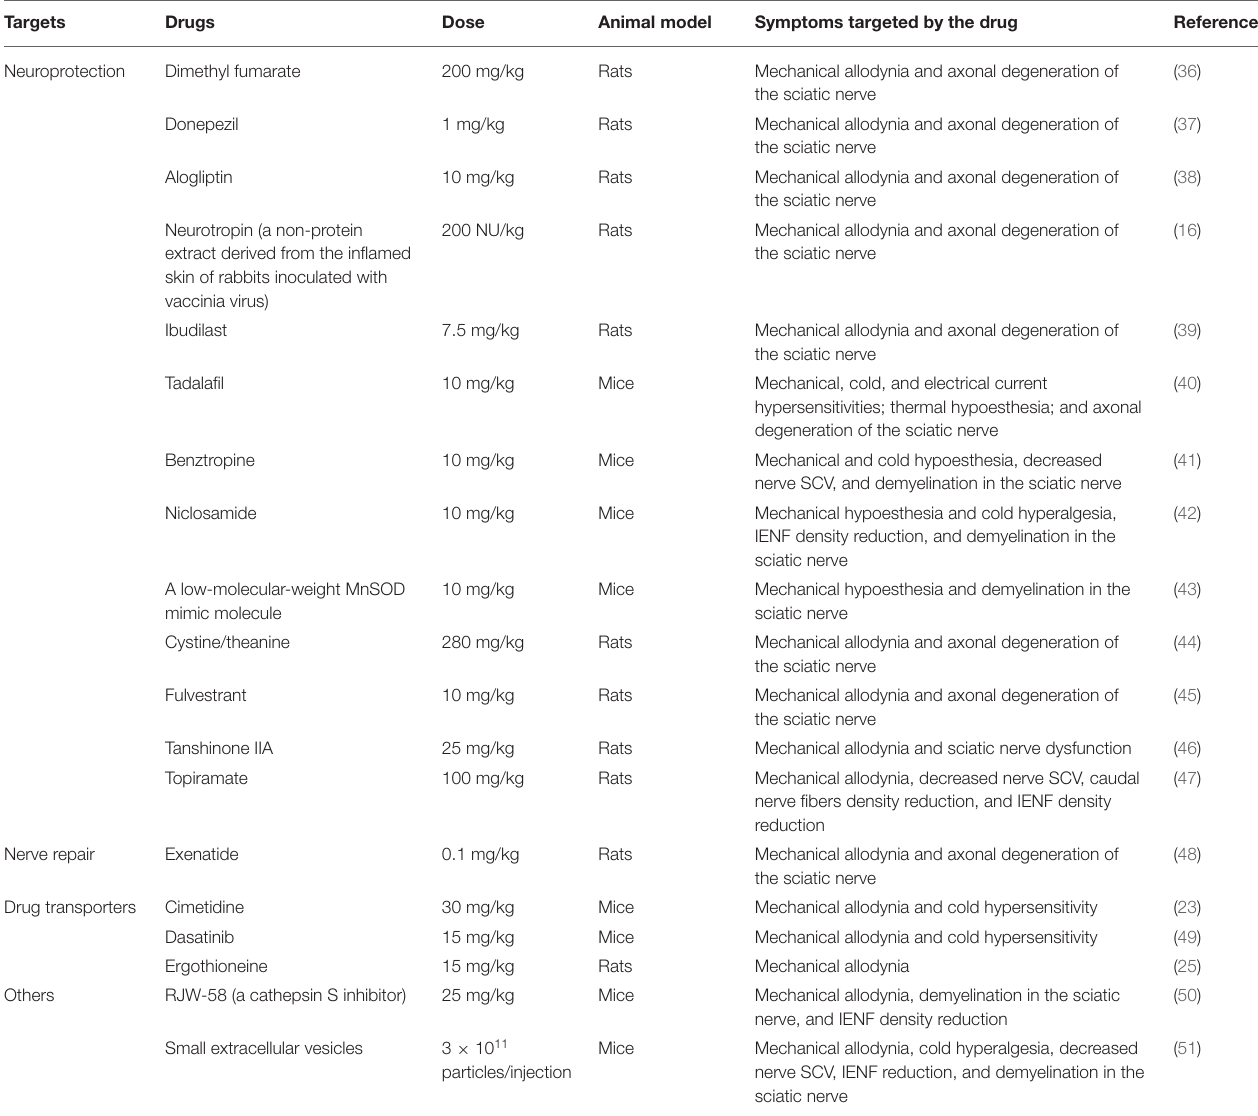
TABLE 1 | Candidate drugs for the prevention of oxaliplatin-induced peripheral neuropathy (OIPN).